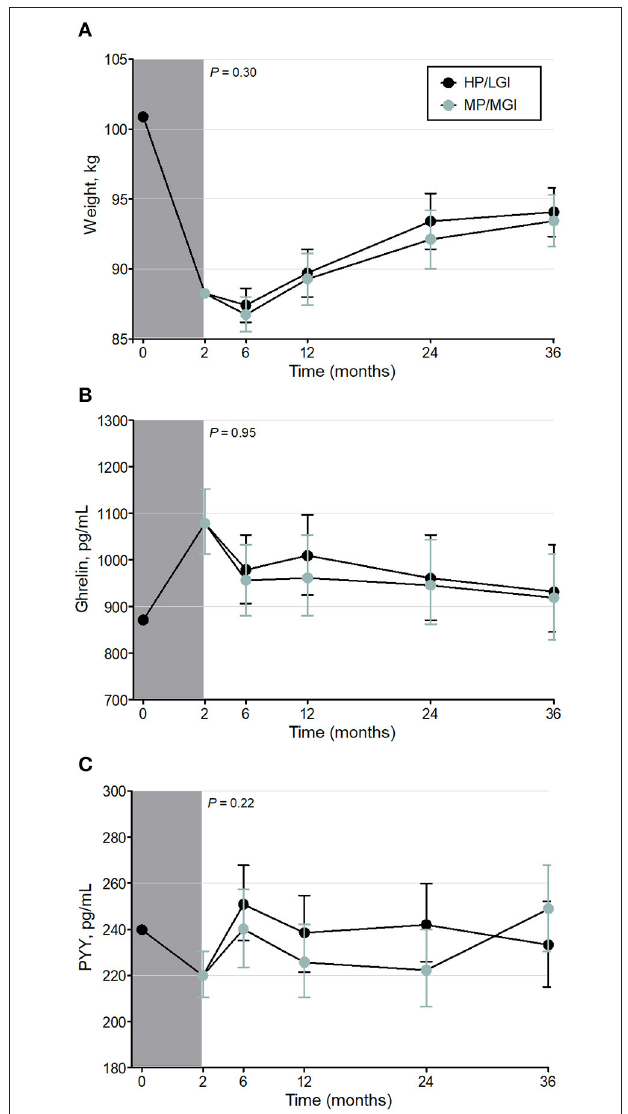
FIGURE 2 | Weight (A) and fasting plasma gut hormone concentrations [Ghrelin (B) and Peptide YY (C) ] before, during, and after the weight-reducing (gray shaded bar) and weight-maintenance diets of the PREVIEW sub-study [either a higher protein/low GI (HP/LGI) or a moderate-protein/moderate-GI (MP/MGI) weight-maintenance diet]. Results of a constrained linear mixed model (2–36 months) are shown as estimated marginal means (i.e., means adjusted for age, sex, exercise group, and the value at 0 months) ± 95% CI. There were no statistically significant differences between the weight-maintenance diets at any time point ( P- values for the interaction of diet*time are shown on each panel). Ghrelin and peptide YY were log-transformed in the